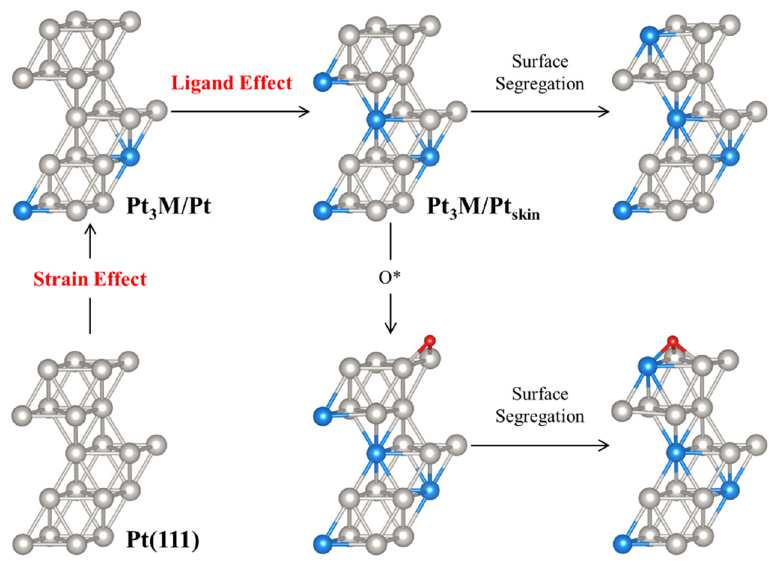
Figure 1. DFT slab models. Gray, blue, and red spheres represent Pt, M, and O atoms, respectively. An asterisk (*) denotes the adsorption state.